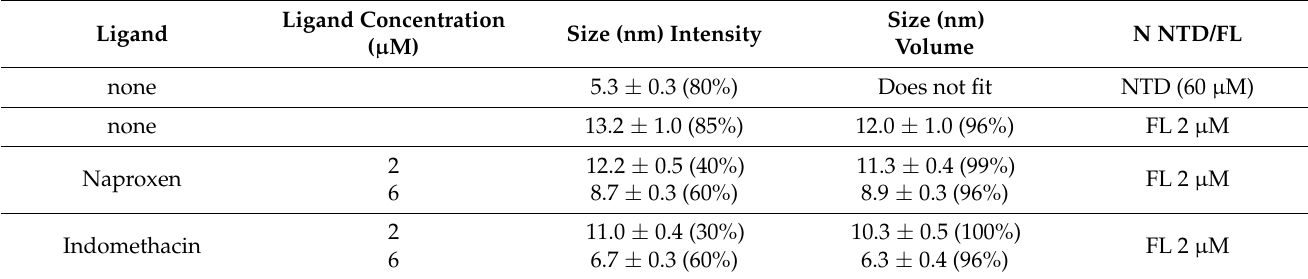
Figure 5. Binding of substance P (1-7) to the wt and the BA5 variant of N. ( A ) Binding site of substance P (1-7) in the wt N colored according to H-bond donor (pink) or acceptor (green) of the cavity; ( B ) 2D plots of the interactions of substance P (1-7) with wt N. Hydrogen bond and ionic interactions are shown as dashed green and orange colored lines, respectively; ( C ) upper: comparison of the flexibility of the wt apo protein (black line) with the wt-substance P (1-7) complex (red line); lower: comparison of the RMSF of BA5 apo (black line) and BA5- substance P (1-7) (complex (blue line); note the large decrease in the movement of the α -helix (R209) due to peptide binding in both complexes; ( D ) Binding site of substance P (1-7) in BA5; ( E ) 2D plots of the interactions of substance P (1-7) with BA5. Table 3. Size of N and its complexes with the studied ligands with or without nucleic acids determined by DLS.